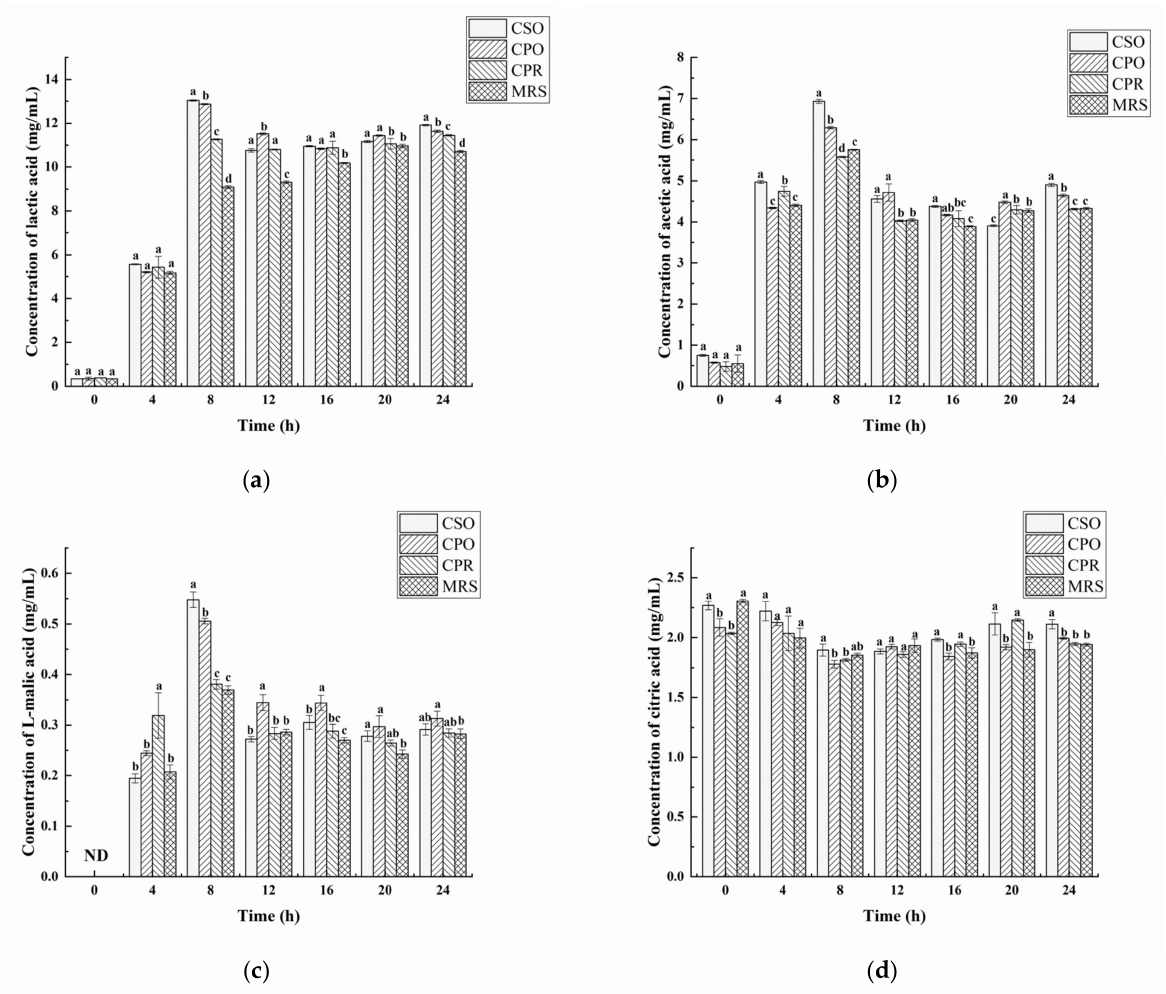
Figure 3. Effects of CSE on organic acids during the growth of L. reuteri . Including lactic acid ( a ), acetic acid ( b ), l-malic acid ( c ), and citric acid ( d ). The Values are presented as mean ± standard deviation ( n = 3). Different letters indicate statistical differences between groups ( p <